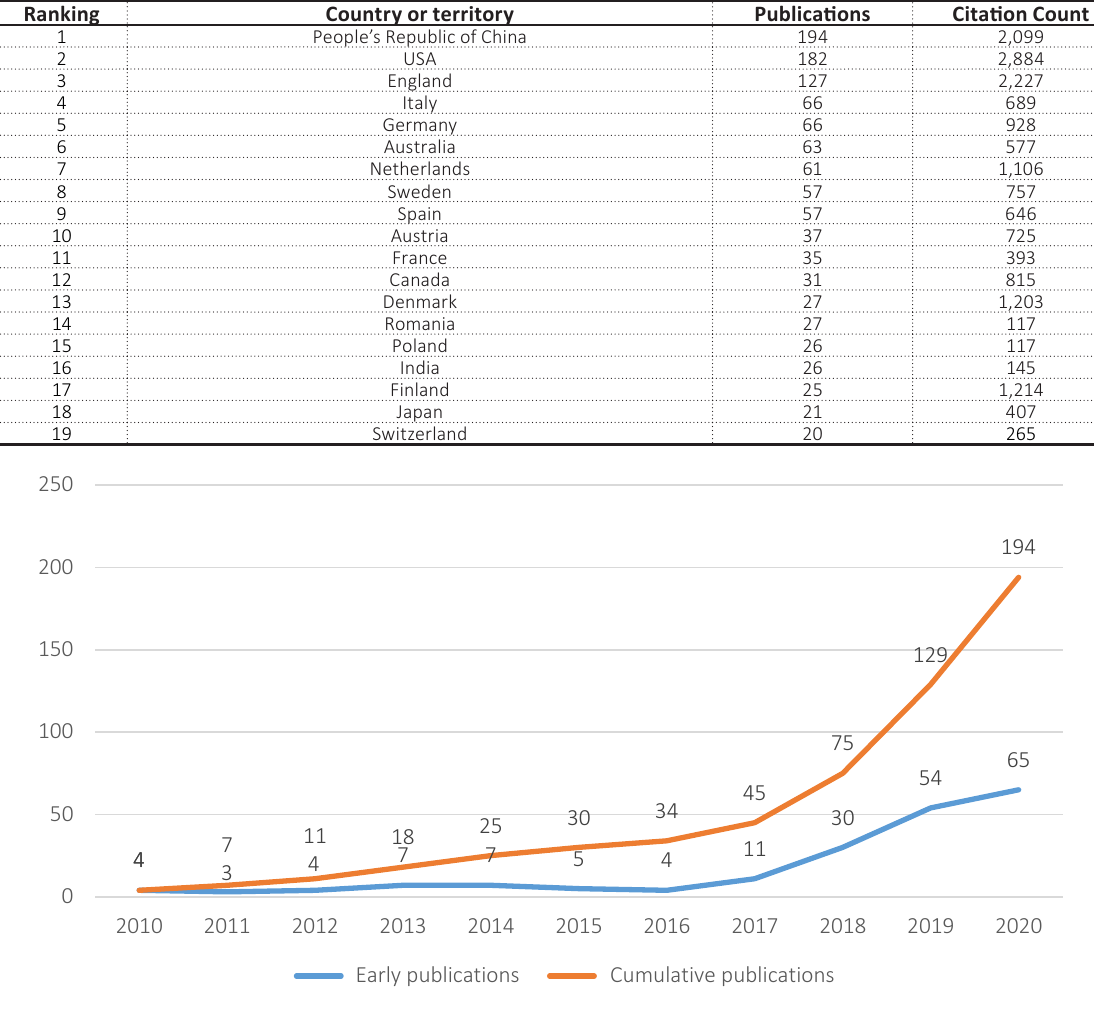
Figure 3. Number of published articles on sustainable development in the sharing economy by